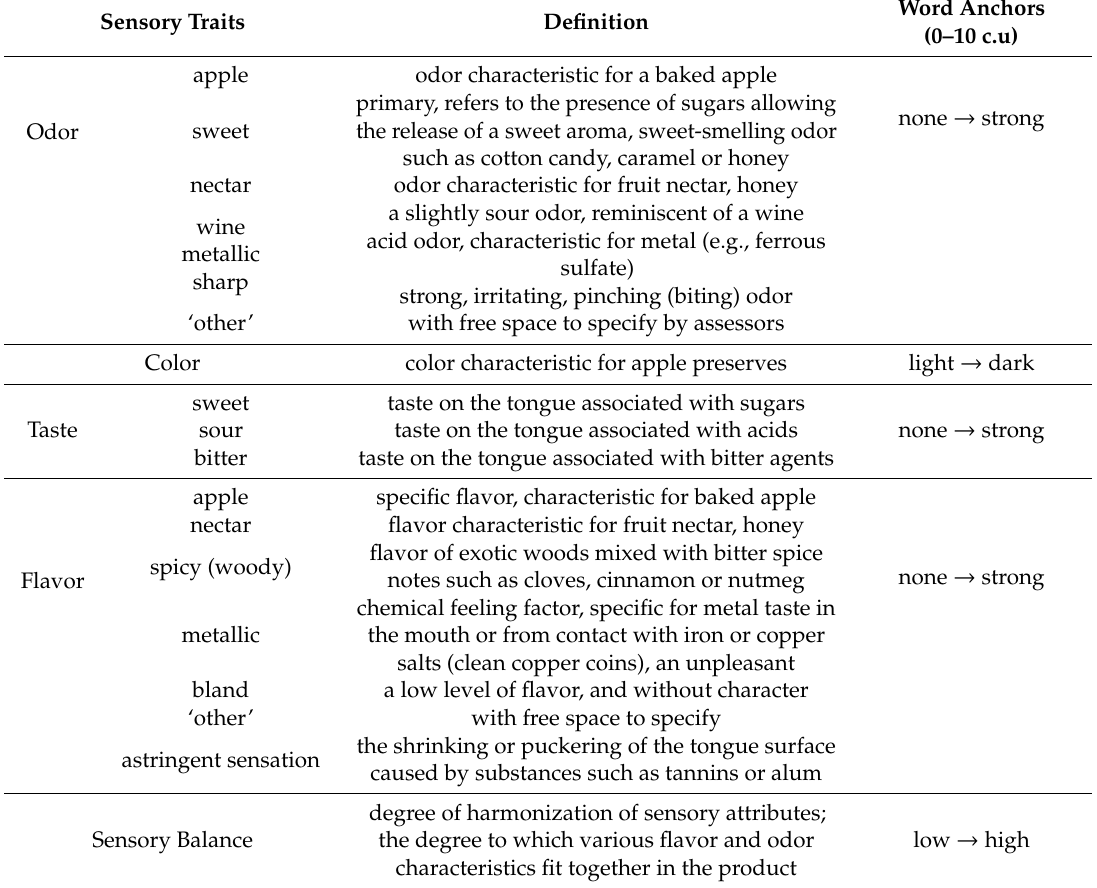
Table 2. Definition of attributes for the descriptive sensory